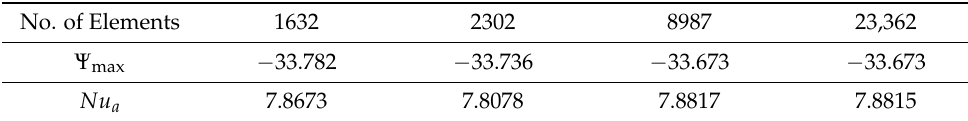
Table 2. Grid independence test for Re = 100, Ste = 0.2, φ = 0 and N = 4. No. of Elements